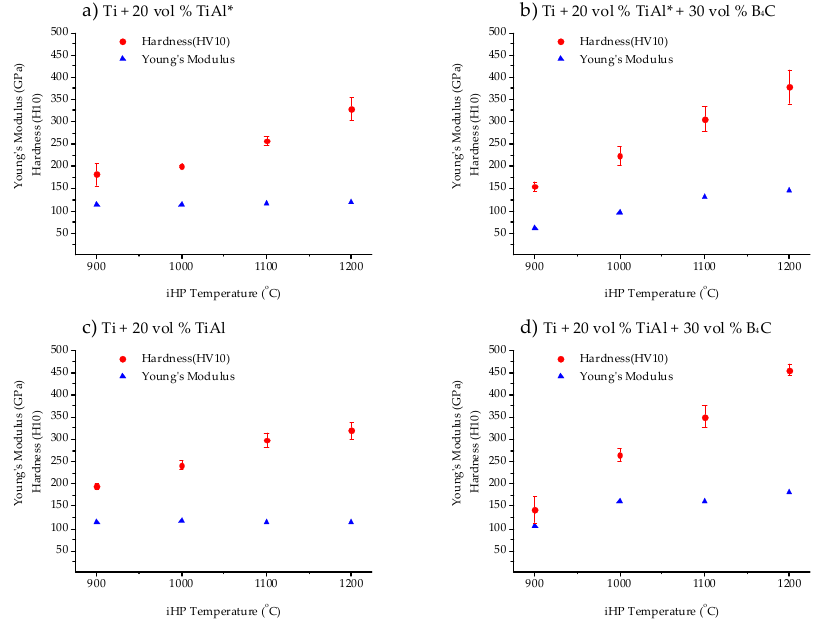
Figure 9. (All the specimens consolidated at 40 MPa). Processing temperature (°C) vs. hardness (HV10) and Young’s Modulus (GPa): ( a ) Ti + 20 vol % TiAl*; ( b ) Ti + 20 vol % TiAl* + 30 vol % B 4 C; ( c ) Ti + 20 vol % TiAl; ( d ) Ti + 20 vol % TiAl + 30 vol %B 4